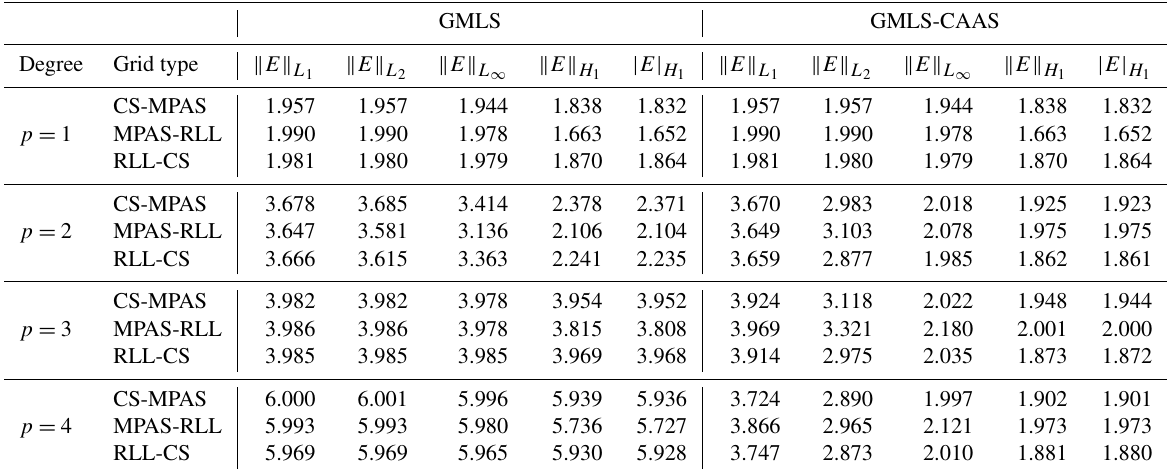
Table 4. GMLS and GMLS-CAAS: convergence rates for the A NALYTICAL F UN 1 field on all mesh types. Note that the superconvergence of gradients for p = 4 appears to be special for A NALYTICAL F UN 1; for A NALYTICAL F UN 2, GMLS converged at about fourth order, as theoretically expected, in (cid:107) E (cid:107) H and | E | H . 1 1